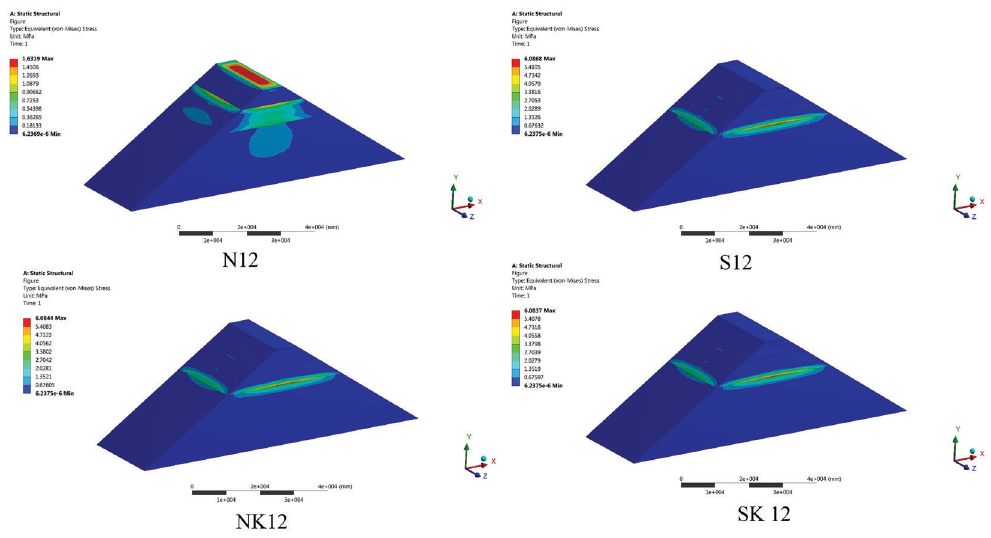
Figure 6. Von Mises Stresses on FEM models for the whole